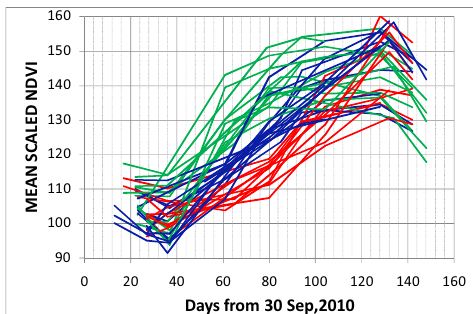
Fig. 5: ISODATA Clusters Temporal Spectral Profiles